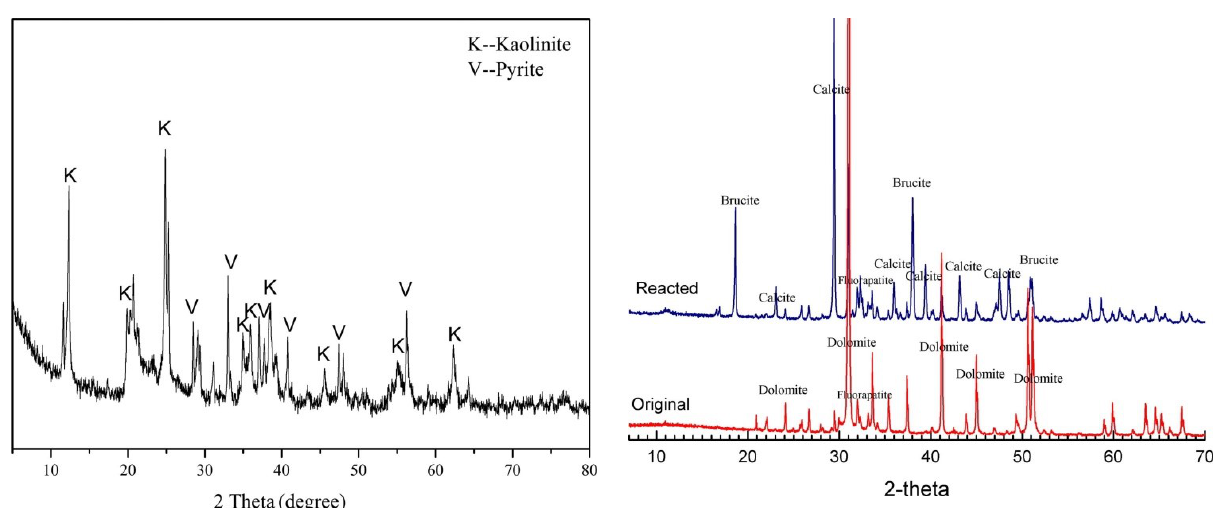
Figure 4: XRD pattern of phosphate tailings before and after alkali- treatment [32] 3 Utilization of tailings as aggregate In general, concrete includes coarse aggregate and fine aggregate, but tailings are merely used as partial or full replacements of fine aggregate, since their particles are fine with a diameter less than 1 mm. The physical prop- erties of tailings have a significant impact on the worka- bility, density, dimensional stability, strength, and dura- bility of concrete. Sometimes tailings, especially